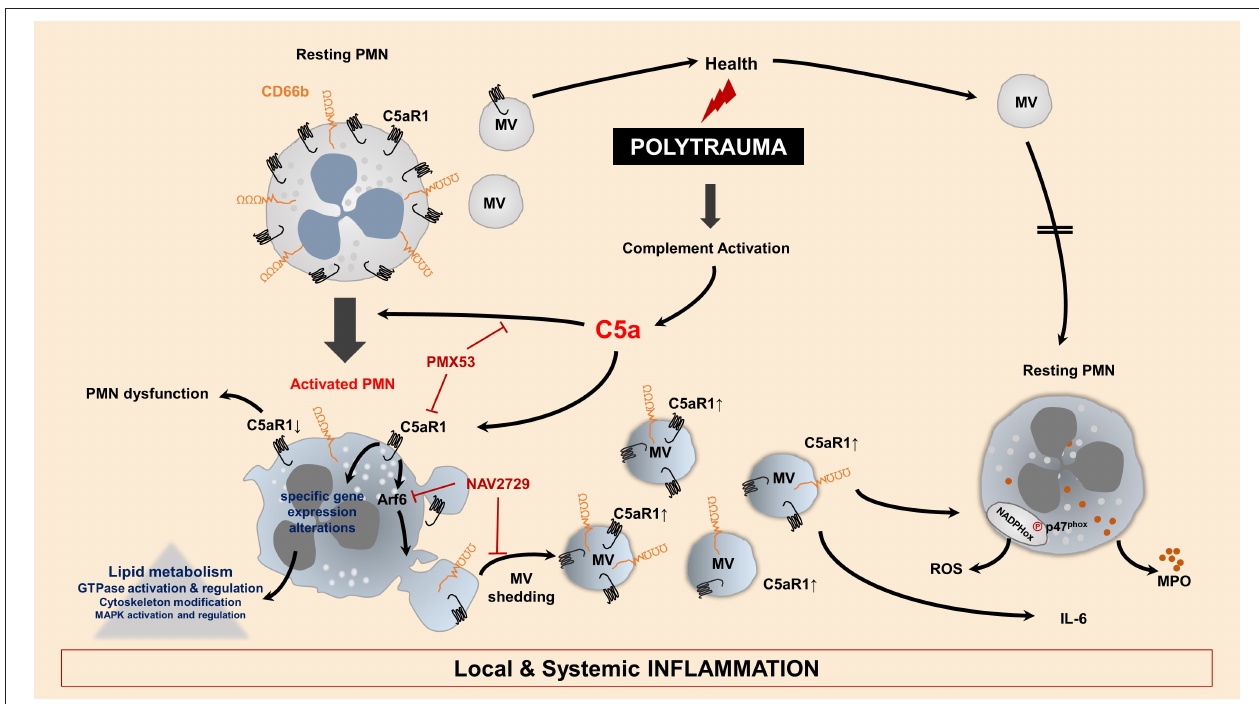
FIGURE 8 | Model for C5a-mediated alterations on MV shedding for neutrophils after PT. PT causes an early activation of complement generating increased C5a concentrations. C5a induces activity of the small GTPase Arf6, which is dependent on C5aR1 signaling. Additionally, specific changes in gene expression pattern are involved in MV shedding. Resting PMNs show physiological MV shedding and composition, which have no inflammatory potential. In contrast, PMNs incubated with C5a loose C5aR1 surface expression induced by C5aR1 signaling and Arf6-mediated shedding of C5aR1-positive MVs. Furthermore, these MVs show increased CD66b and C5aR1 expression, which show pro-inflammatory features when incubated with resting PMNs. C5a induces shedding of MVs, which lead to NAPDH oxidase activation, ROS generation and MPO release in resting PMNs. Moreover, IL-6 generation was observed when these MVs were incubated in whole blood. PMX53 and the Arf6-selective compound NAV2729 can block the shedding of C5aR1-positive MVs from PMN surfaces and its inflammatory